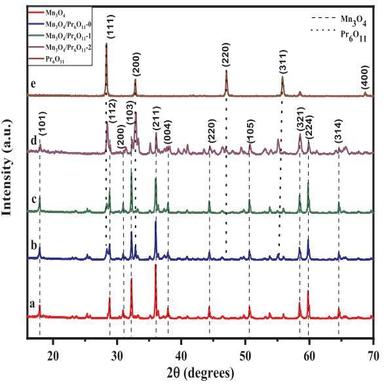
XRD patterns of Mn3O4 (a), Pr6O11/Mn3O4-0 (b), Pr6O11/Mn3O4-1 (c), Pr6O11/Mn3O4-2 (d) and Pr6O11 (e).